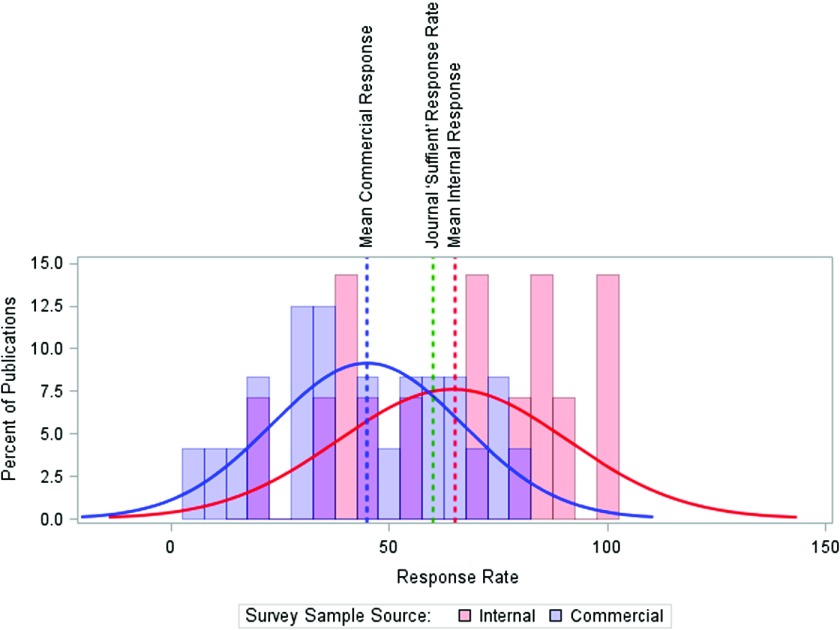
Response Rate by Survey Sample Source. Note: The median response times are slightly higher than the mean: 47% for commercially-available sources, 71% for non-commercially available internal member lists. Source: n = 75 published reports of US physician surveys, 2000–2014.